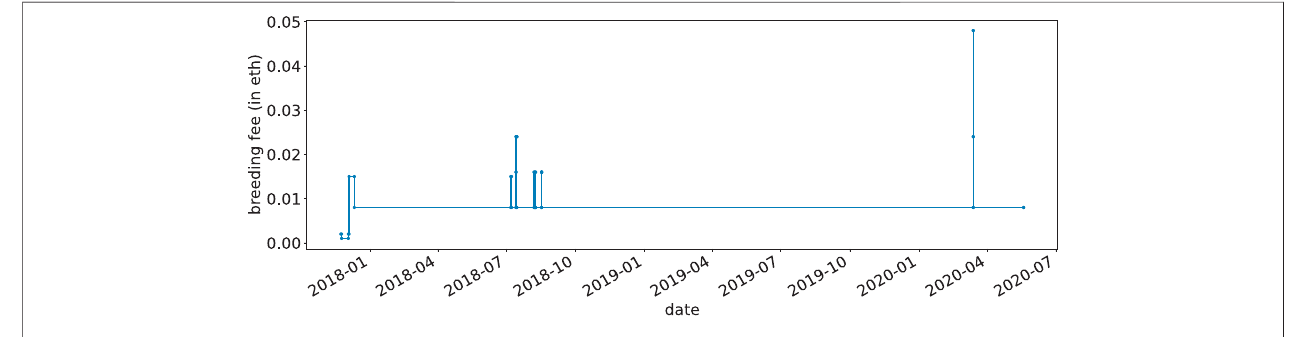
FIGURE 1 | Changes of the breeding fee.